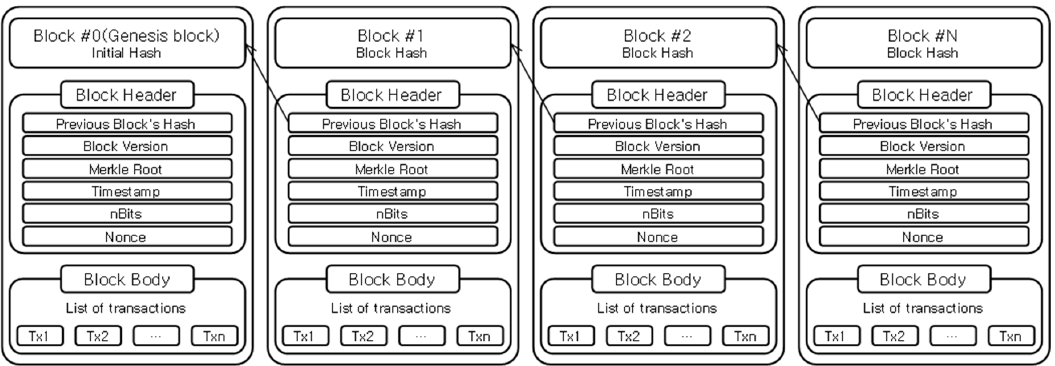
Figure 2. The structure of